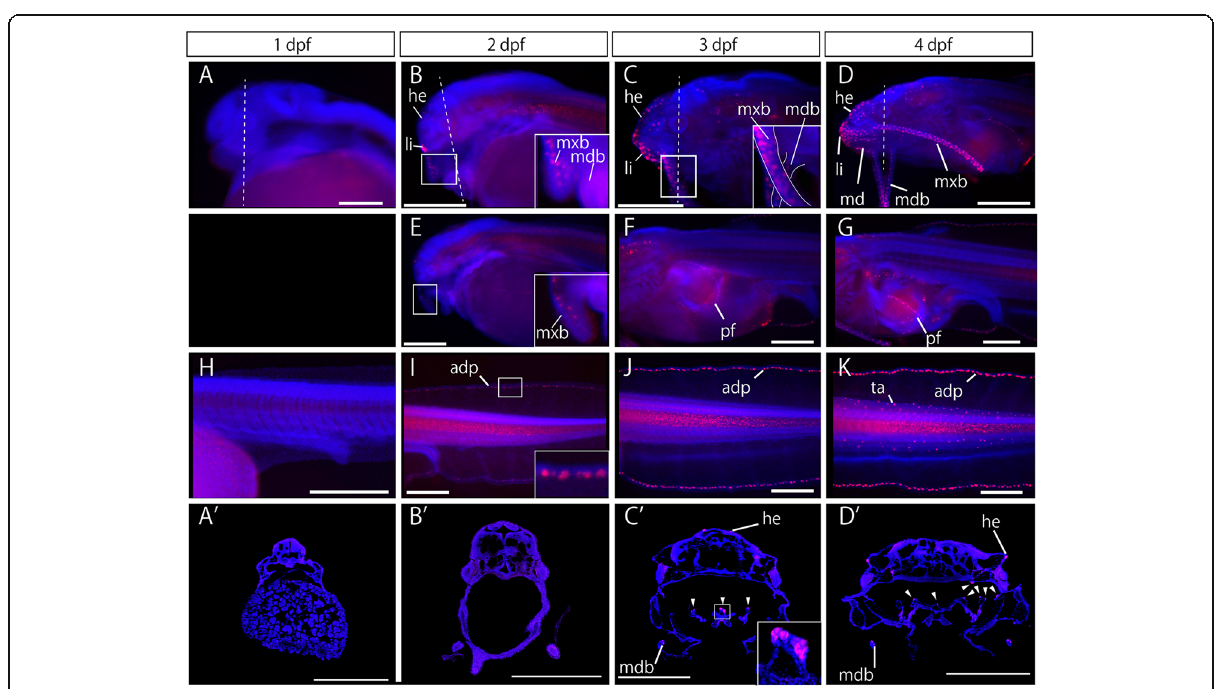
Fig. 2 Taste bud development of Amur catfish. Catfish embryos at 1 dpf (a, h, a ′ ), 2 dpf (b, e, i, b ′ ), 3 dpf (c, f, j, c ′ ), and 4 dpf (d, g, k, d ′ ) observed using fluorescent macroscopy. Lateral views are shown in a – k. Taste buds of the head (a – g) and trunk and tail (h-k) regions were visualized by anti-calretinin antibody (in red). Coronal sections of the oral cavity are shown in a ′– d ′ . The dashed line in a – d indicates the cutting plane in a ′– d ′ . Taste buds in the oral cavity are indicated by arrowheads. Blue staining shows nucleus labeled by DAPI. Insets in b, c, e and c ′ indicate high magnification images of boxes in b, c, e and c ′ . adp, adipose fin; he, head region; li, lip; mdb, mandibular barbel; mxb, maxillary barbel; pf, pectoral fin; ta, tail region. Anterior is left in a – k. Scale bars in b – g, i – k and b ′ -d ′ are 500 μ m, and 200 μ m in a, h and a